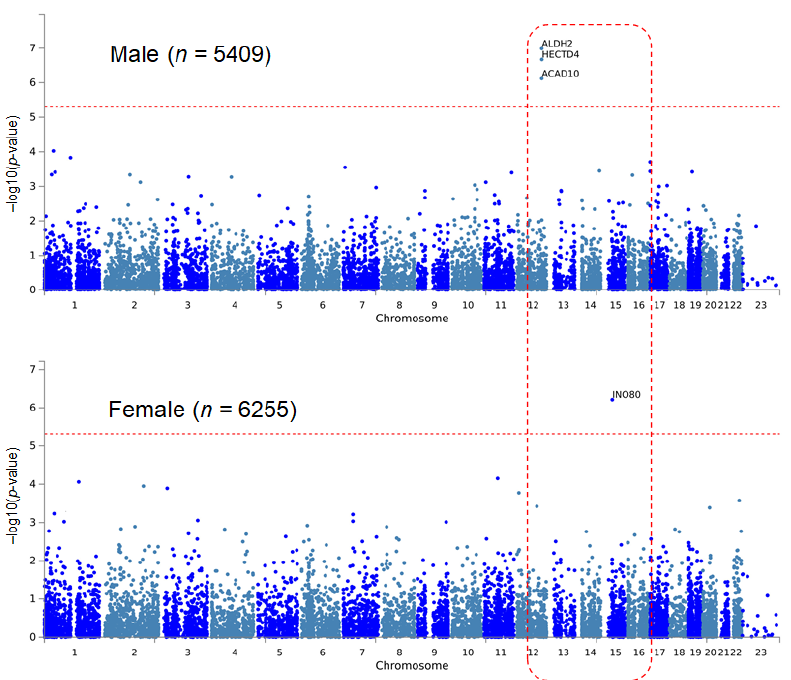
Figure 2. Manhattan plots of sex-stratified MAGMA analysis for systolic blood pressure. As in the same analysis for hypertension, ALDH2, HECTD4, and ACAD10 show significant results only in the male